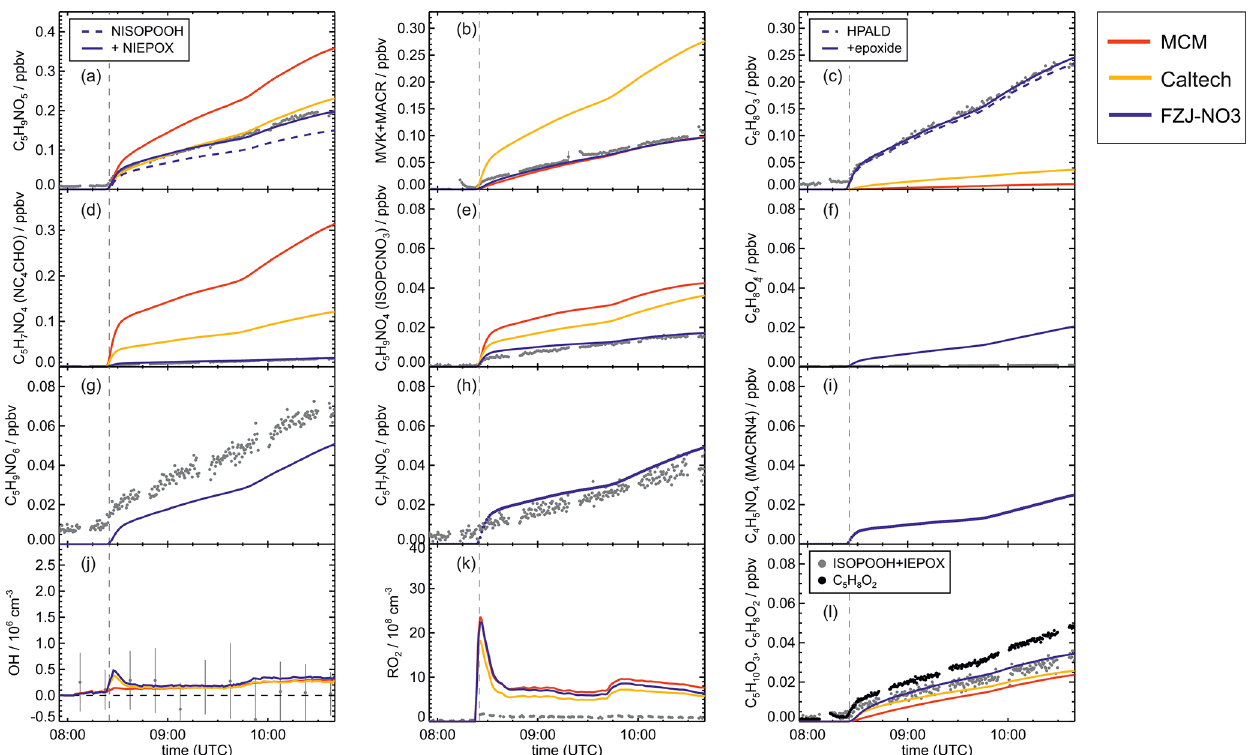
Figure A5. Comparison of results from model calculations applying the different isoprene NO 3 chemistry mechanisms for the experiment on 10 August 2018 (Experiment 2). MVK, MACR, NISOPOOH, ISOPCNO 3 and NC 4 CHO are produced from all mechanisms, whereas the other compounds are only produced from either 1,6-H-shift reactions or ring-closure reactions of nitrate alkoxy radicals, which are only implemented in the FZJ-NO3 mechanism. Grey and black dots are measured values. Measured organic peroxy radical concentrations only include part of the total RO 2 because the LIF instrument cannot detect a fraction of nitrate RO 2 (Vereecken et al., 2021). Organic products were detected by the Vocus PTR-MS instrument, which was only calibrated for MVK and MACR. All other traces are scaled to match best the results from the FZJ-NO3